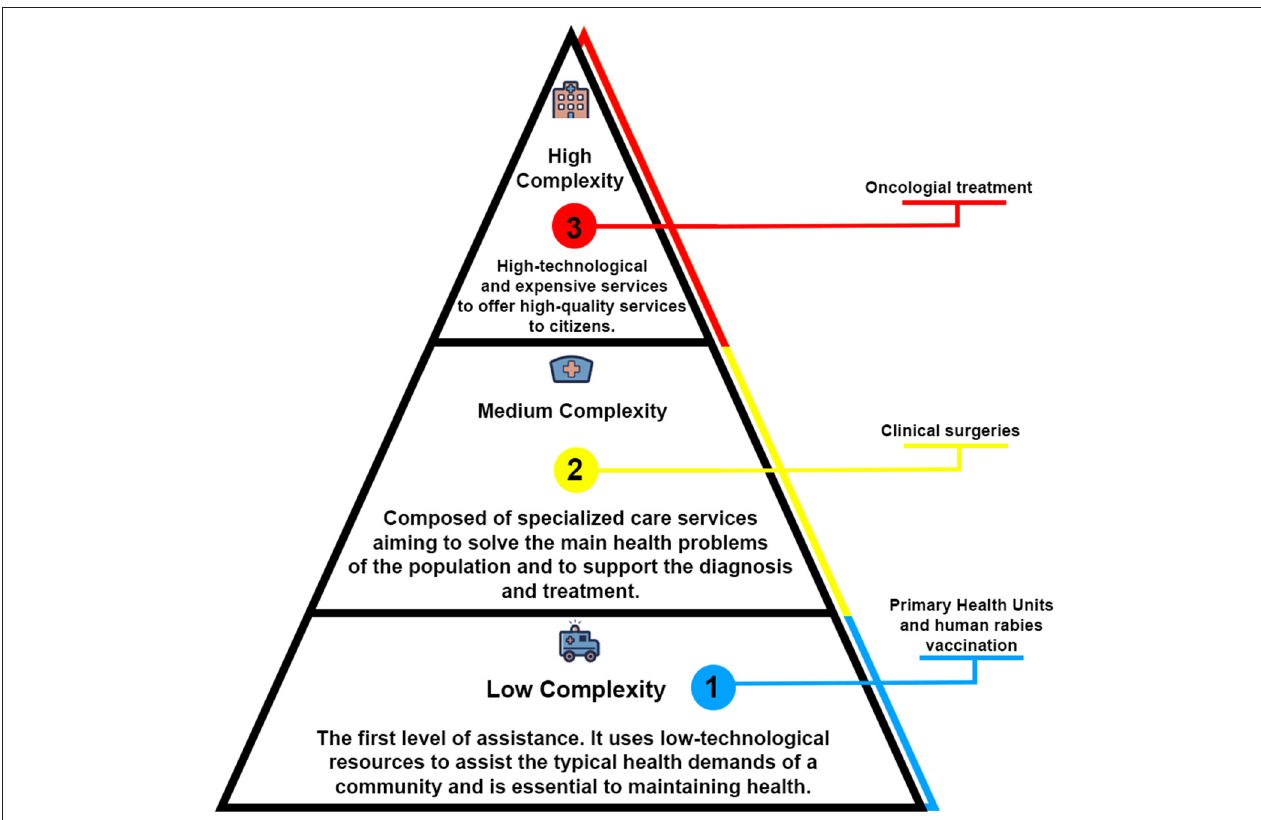
FIGURE 1 | The levels of health care in the context of Brazil’s system. The organizational health system’s model follows the WHO’s recommendations to divide levels of assistance according to health units’ resources available to meet the patient’s demands. The primary level works in a preventable approach by promoting close contact with the community. It may also offer free access to vaccines and medicine. The second level comprises hospitals and care centers that provide ambulatorial assistance to solve the main health problems. The third level offers high-cost and high-specialized treatments for the patient’s rehabilitation, including Intensive Care Units and oncologic